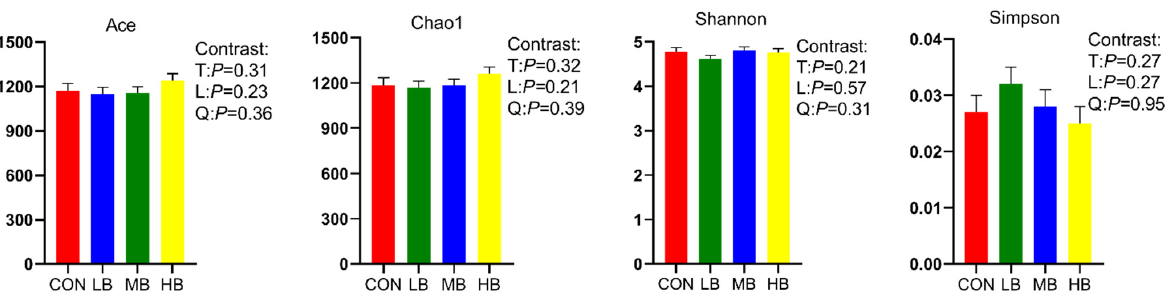
Figure 1. Alpha diversity index of lactating dairy cows fed treatment diets. CON (control, no by- products), low by-products (1.67%) (LB: 0.83% SH + 0.84% BP), medium by-products (3.33%) (MB: 1.67% SH + 1.66% BP), and high by-products (5%) (HB: 2.5% SH + 2.5% BP) (DM basis). T, treatment effect; L, linear effect; Q, quadratic effect.